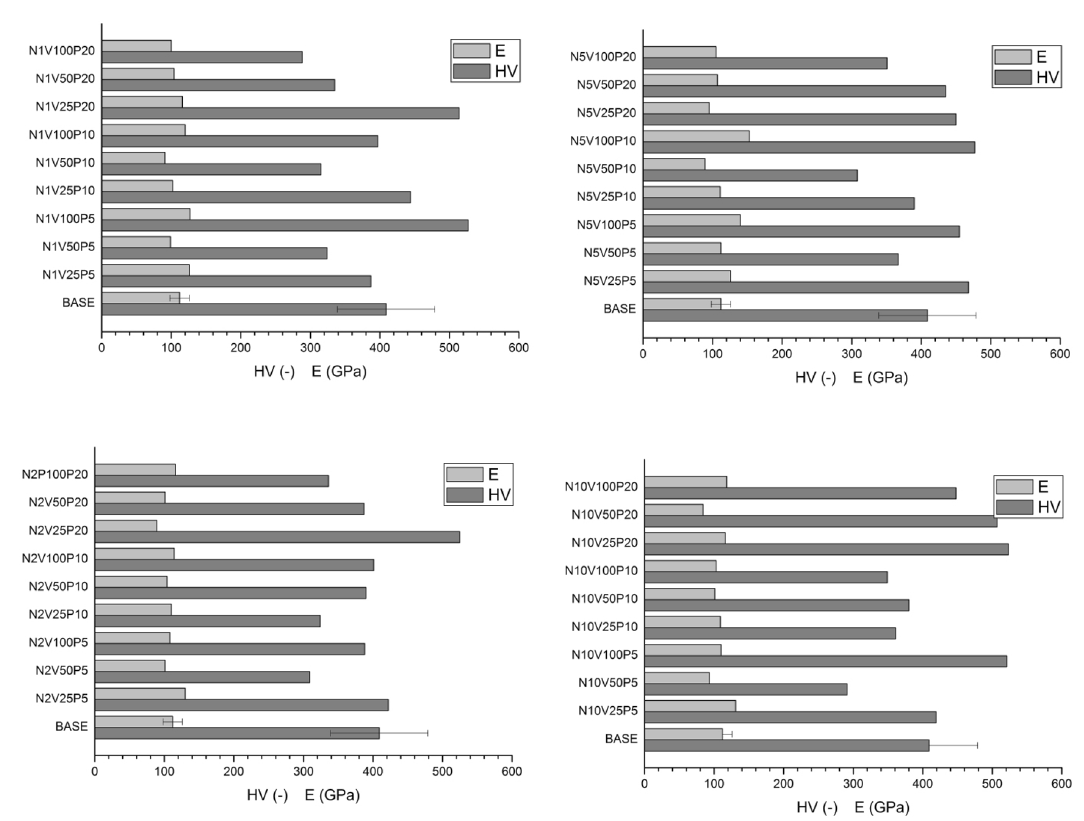
Figure 6. Values of the Vickers hardness (HV) and elastic modulus (E) for each sample, compared to the base material values. The error bars apply to all data. Table 4. Water drop test results for each sample. WR is for the Water Repellent conditions.